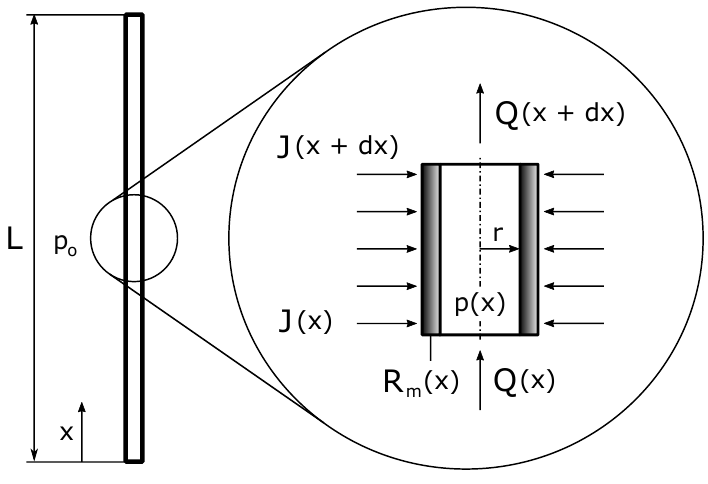
Figure 1. Model sketch with details for a short membrane section of length d x